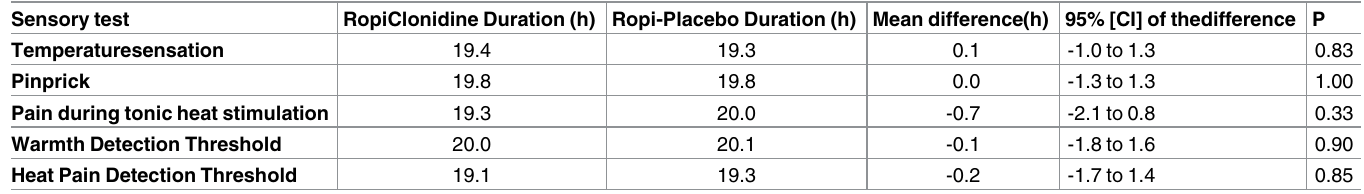
Table 1. Results. Sensory test